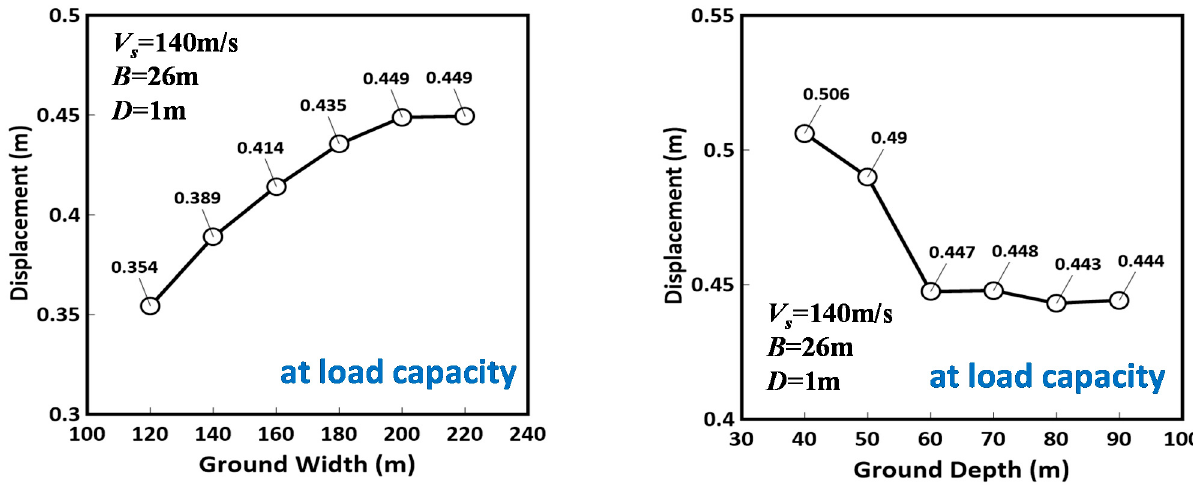
Figure 4. Solution convergence on FE analytic zone in this study.